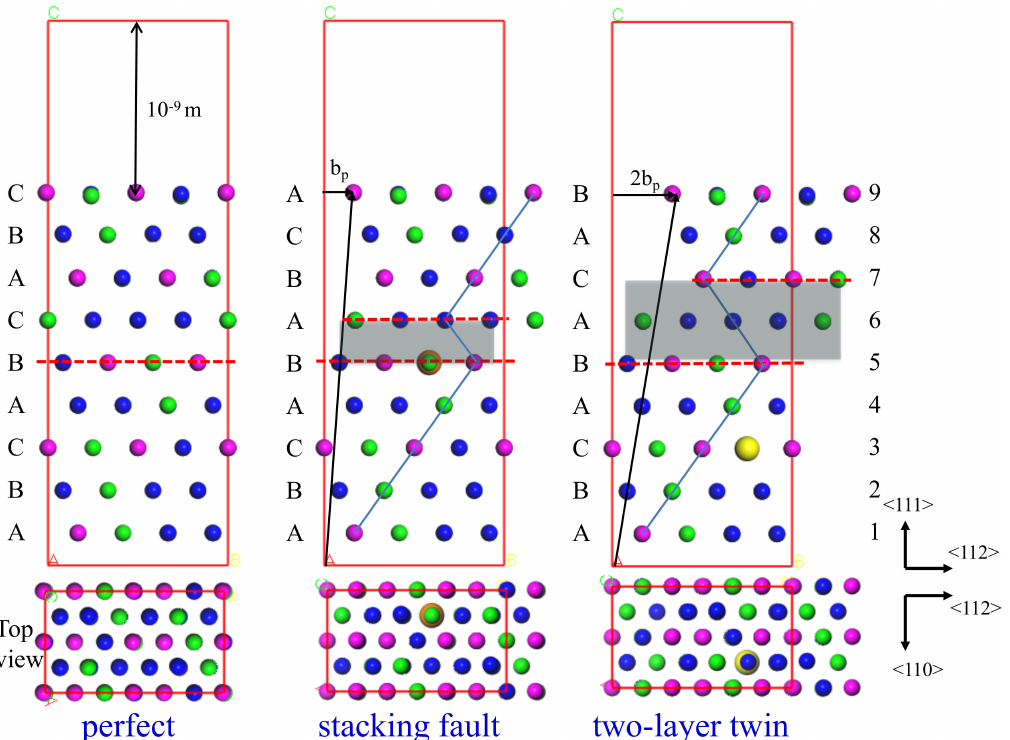
Figure 2. A schematic illustration of the formation process of